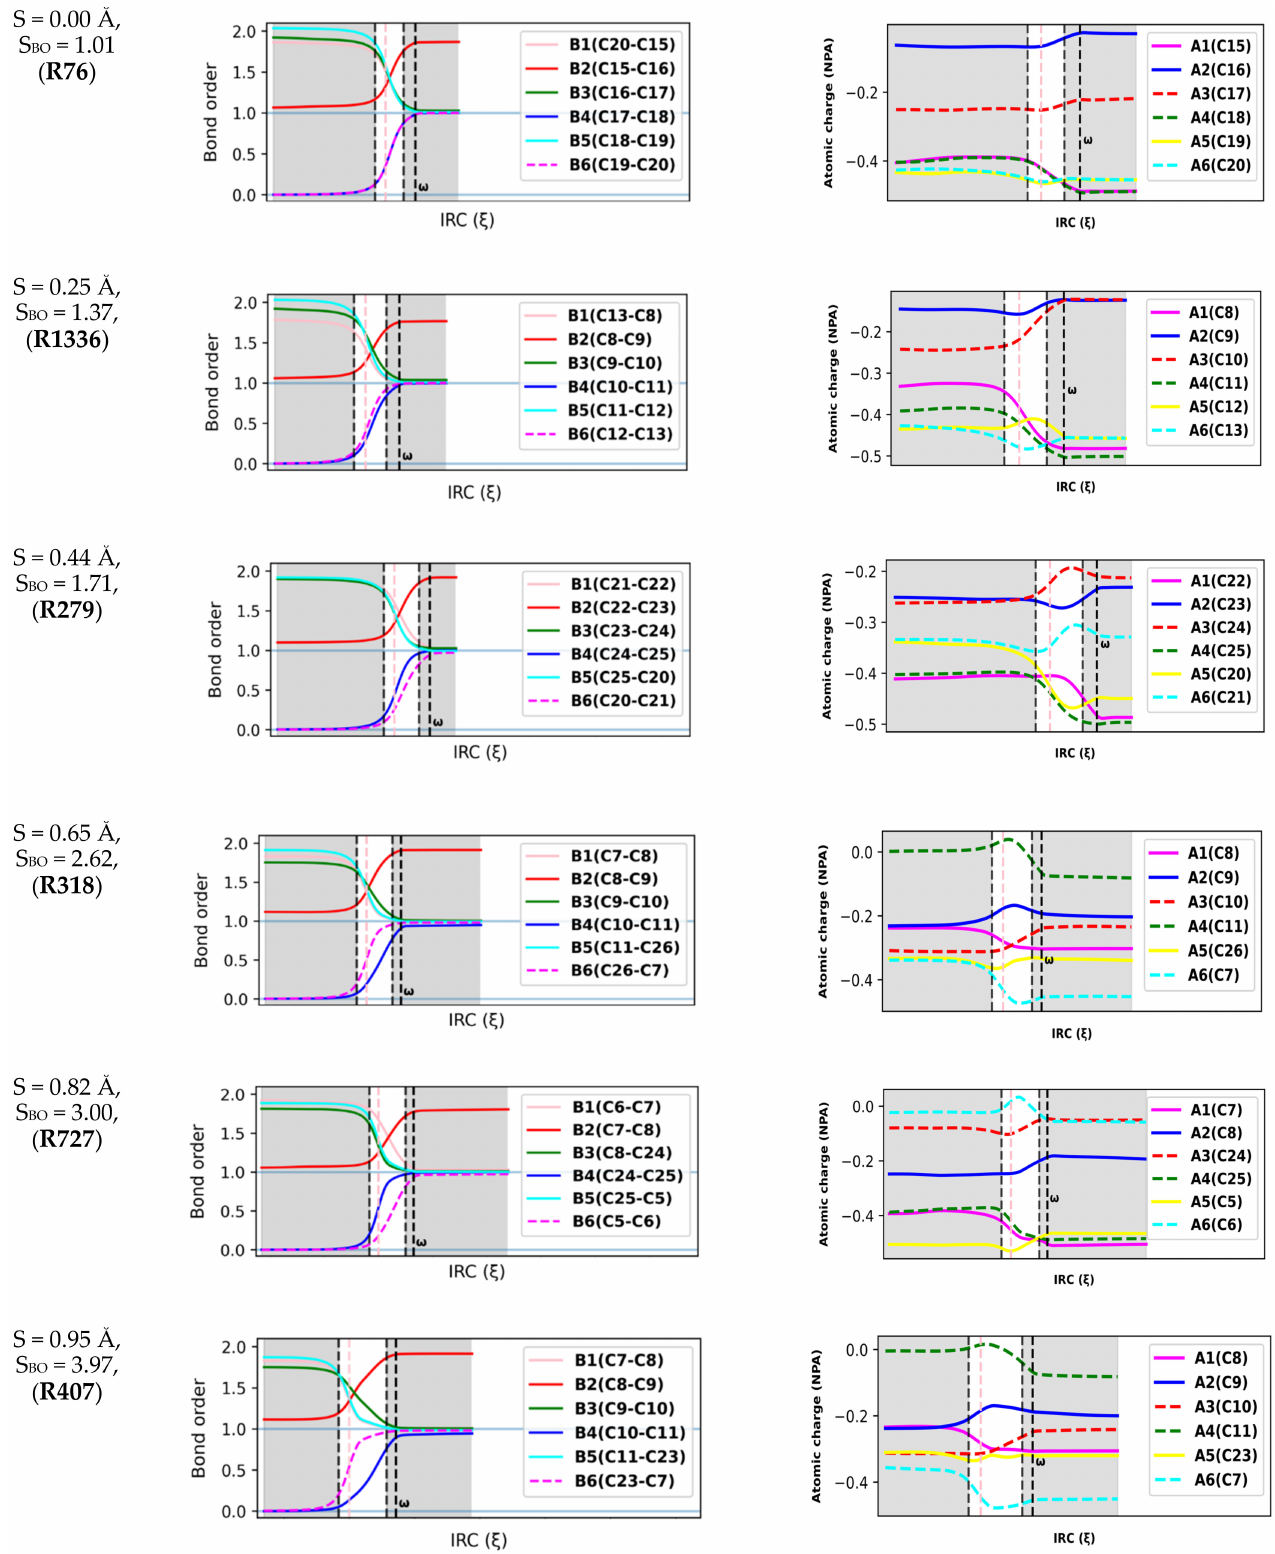
Figure 5. Bond order and atomic charge analysis of an illustrative set of six Diels–Alder reactions. The position of the maximum of κ is marked ( ω ) . The TS regions are shown in white, and the TS is shown by the pink dashed vertical